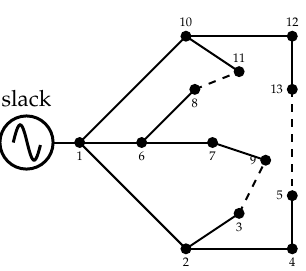
Figure 2. Electrical configuration of a radial/mesh distribution network (adapted from [31]).